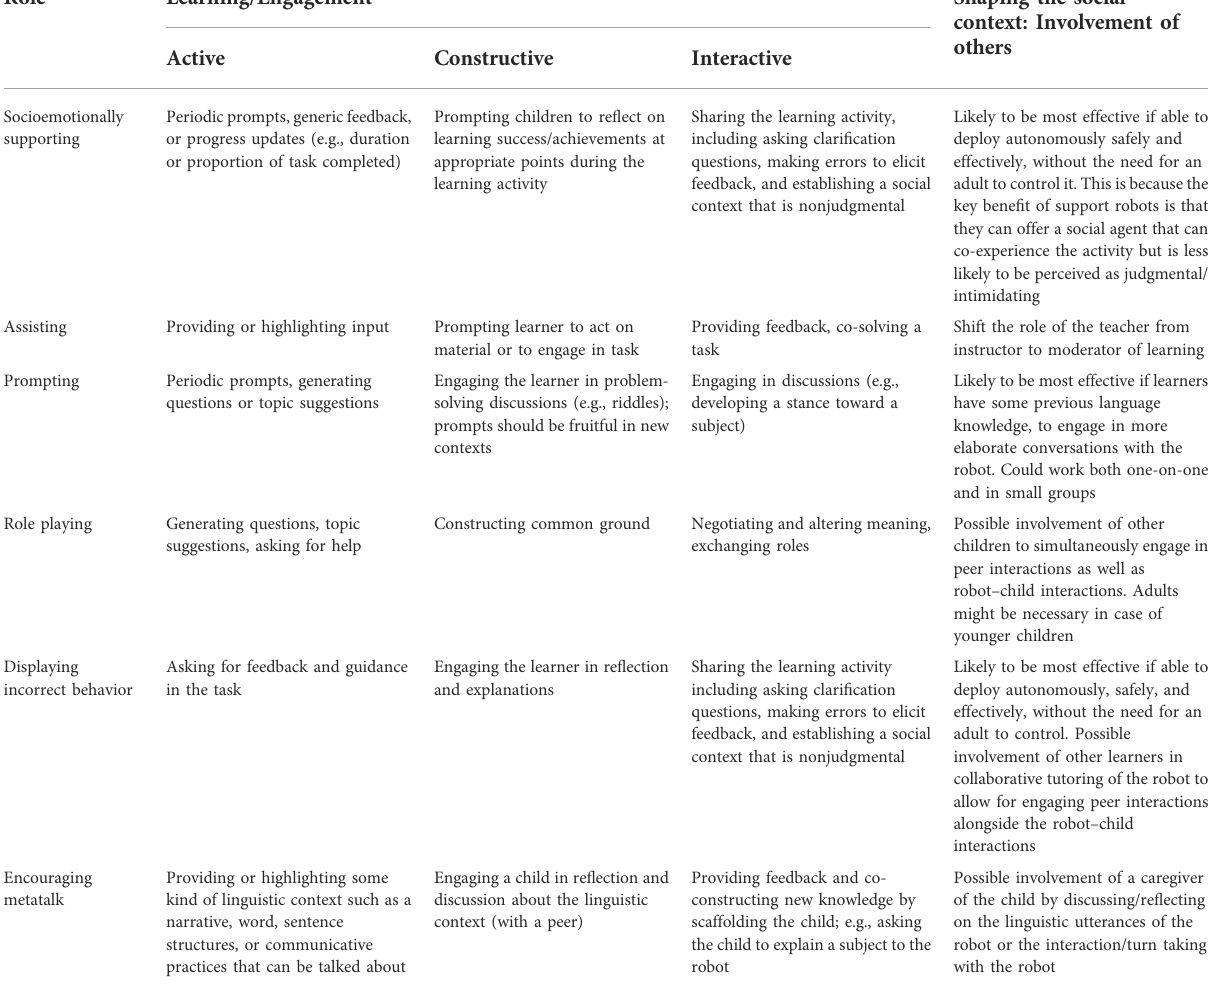
TABLE 2 Potential of innovative roles with respect to engagement and involvement of